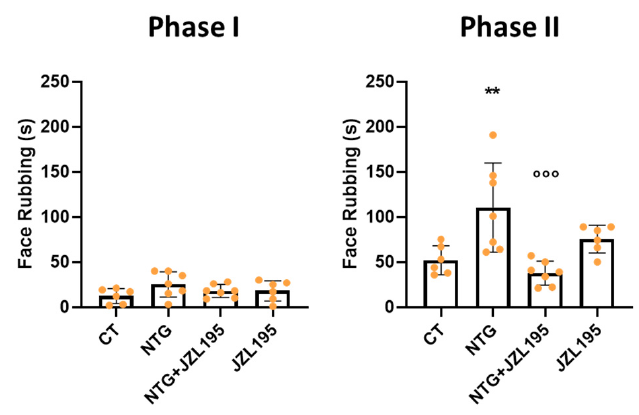
Figure 4. Phases I and II of the orofacial formalin test. Male Sprague–Dawley rats were treated with JZL195 at a dose of 3 mg/kg (i.p.) dissolved in a volume of 2 mL/kg of vehicle (Tween- 80/polyethylene glycol 200/saline) 2 h after NTG or vehicle injection. The nocifensive behavior was evaluated 4 h after NTG or vehicle injection. Data are expressed as mean of face rubbing time (in seconds) ± SD. One-way ANOVA followed by Tukey’s multiple comparisons test; ** p < 0.05 vs. CT; ◦◦◦ p < 0.001 vs. NTG. CT: control group ( n = 6); NTG: nitroglycerin group ( n = 7); NTG + JZL195: nitroglycerin + JZL195 group ( n = 7); JZL195: nitroglycerin vehicle + JZL195 group ( n =